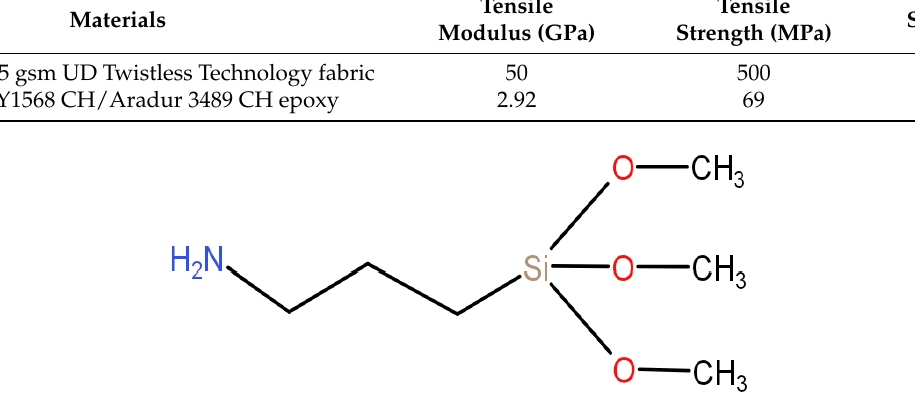
Figure 1. 3-aminopropyltrimethoxysilane coupling agent.